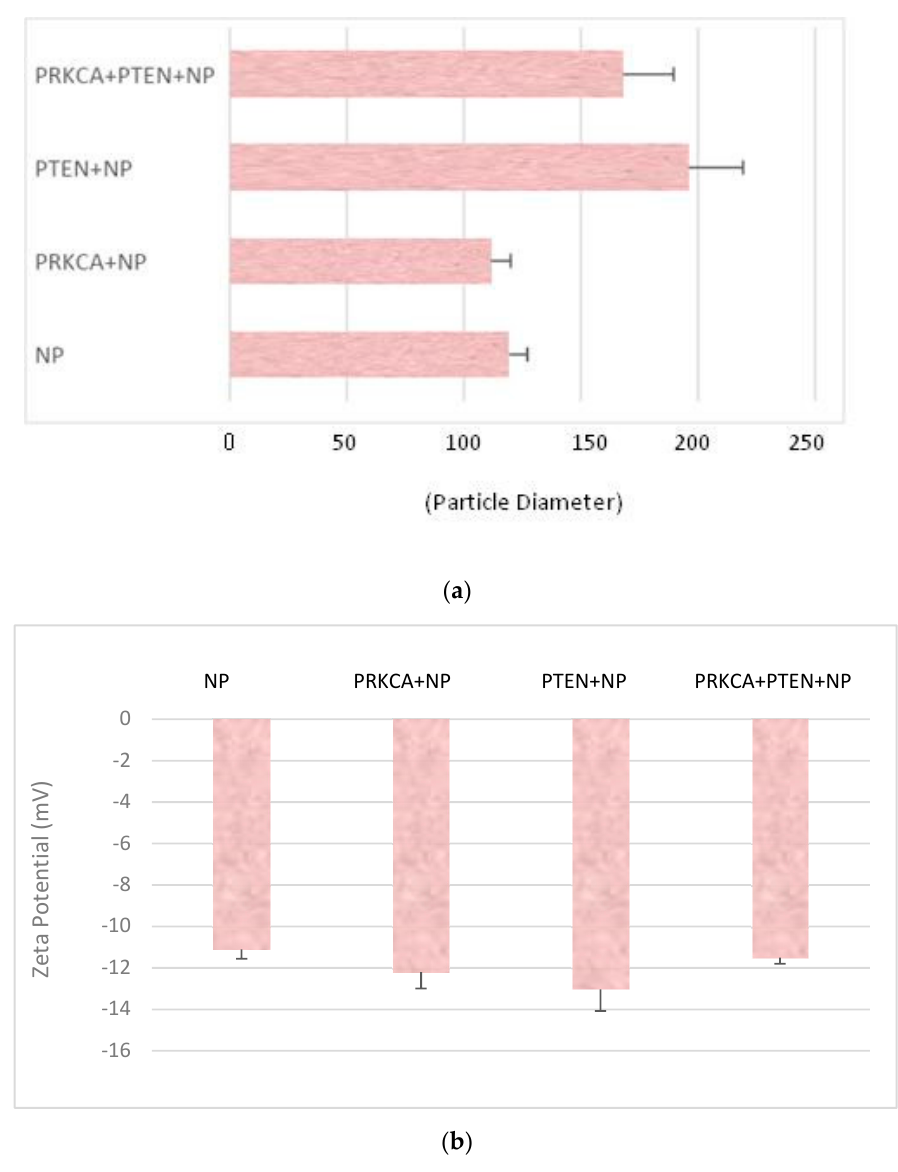
Figure 1. ( a ) Size and ( b ) zeta potential measurements of NPs alone, PRKCA+NPs, PTEN+NPs and PKCA+PTEN+NPs formed with addition of 4 mM of exogeneous Ca 2+ in 1 mL DMEM medium and incubation at 37 °C for 30 min. Each of the measurements performed three times and mean and standard deviation were